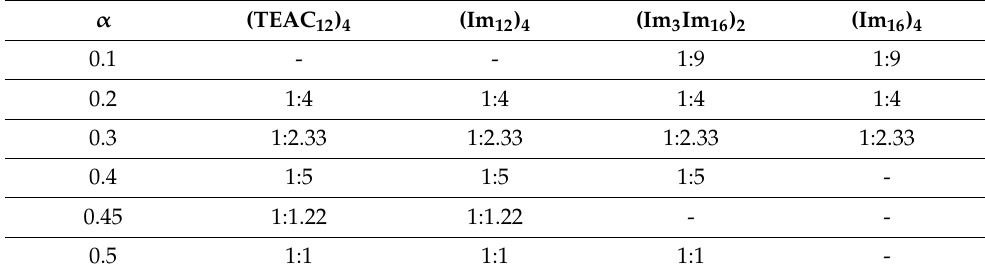
Table 1. Composition (mole ratio) of the CAL/DOPE liposomes